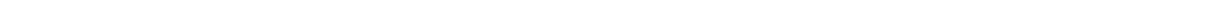
Fig. 4 KIFC1 is speci fi cally required for survival of cancer cells exhibiting centrosome ampli fi cation. a Centrosome ampli fi cation (CA) scores for panel of breast cancer cell lines. Cell lines were dichotomized into low CA (black) and high-CA (red) groups. b Representative immuno fl uorescence images showing centrosome marker Aurora A (green) and centriole marker CP110 (red) used for calculating CA score. Scale bar is 5 μ m. Top right inset shows red channel, bottom right inset for each image shows green channel. c Mean normalized percent inhibition (NPI) of panel of cell lines dichotomized into low and high-CA groups for siRNA #2, #4, #5, and #6. Error bars represent the SEM, n > 3. Student's t test: ** p < 0.01, *** p < 0.001, **** p < 0.0001. d Colony formation assay of two low centrosome-ampli fi ed cell line (CAMA1 and SUM149) and two high-centrosome-ampli fi ed cell lines (MDA-MB-231, HCC1954 and BT20) infected with either non-targeting shRNA (NT) or shRNA-targeting KIFC1 (KIFC1 shRNA). Cells were grown for 14 – 21 days in the presence or absence of doxycycline, fi xed and stained in crystal violet and colonies quanti fi ed. Mean surviving fraction normalized to NT, error bars represent the SEM, n = 3. One-way ANOVA with Tukey ’ s multiple comparisons test: *** p < 0.001, **** p < 0.0001. e NPI of MDA-MB-231 cells infected with either GFP alone (GFP) or GFP-tagged RNAi-resistant KIFC1 (GFP-KIFC1 r ) with KIFC1 siRNA #4 and #6. Error bars represent the SEM, n = 3, one-way ANOVA with Tukey ’ s multiple comparisons test: * p < 0.05, ** p < 0.01. f Colony formation assay of MDA-MB-231 cells infected with inducible KIFC1 shRNA and infected with inducible RNAi-resistant HA-tagged KIFC1 (KIFC1-HA r ) or with empty vector (EV) control. Mean surviving fraction normalized to NT, error bars represent SEM, n = 3. One-way ANOVA with Tukey ’ s multiple comparisons test: **** p < 0.0001. g Nude hosts were orthotopically injected with either MDA-MB-231 or HCC1954 cells with inducible KIFC1 shRNA and were treated with (red) or without (black) doxycycline when tumors reached >2 × 2 mm (4.2 mm 3 ). Mean tumor volumes at time points indicated, error bars represent the SEM, from two independent experiments. Two-way ANOVA with Sidak ’ s multiple comparisons test: * p < 0.05, ** p < 0.01, **** p <